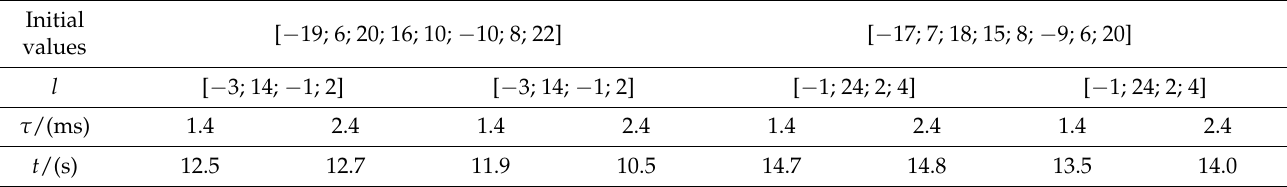
Table 2. System synchronous convergence time comparison table.